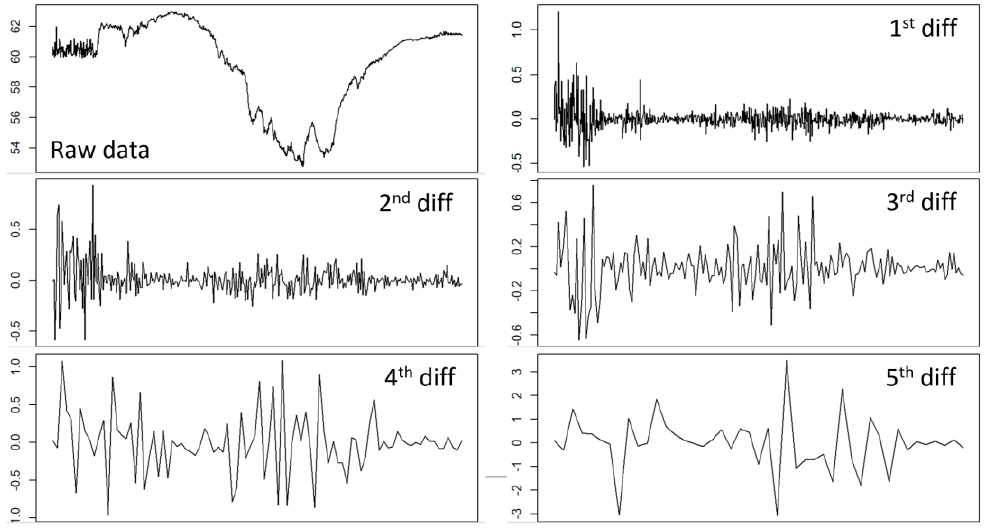
Figure 6. Example of data conversion using DTW.